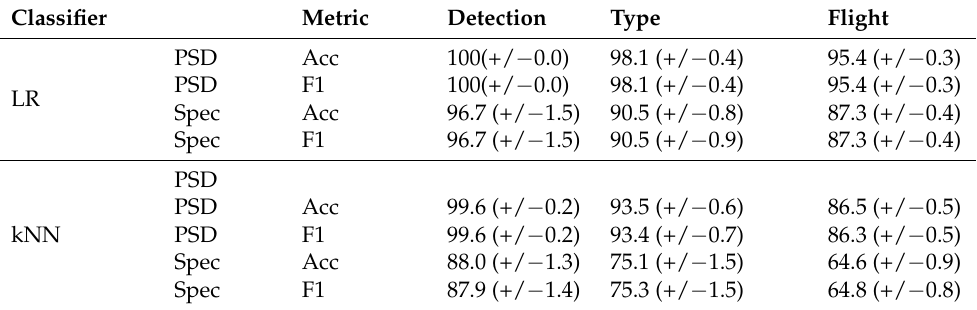
Table 5. Results accuracy (%) and F1-score